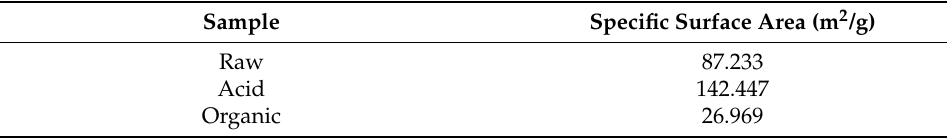
Figure 3. N 2 Adsorption isotherms (77.5K) of raw ( a ), acid functionalized ( b ) and organo-functionalized samples ( c ). Table 3. Surface areas of raw and functionalized samples.